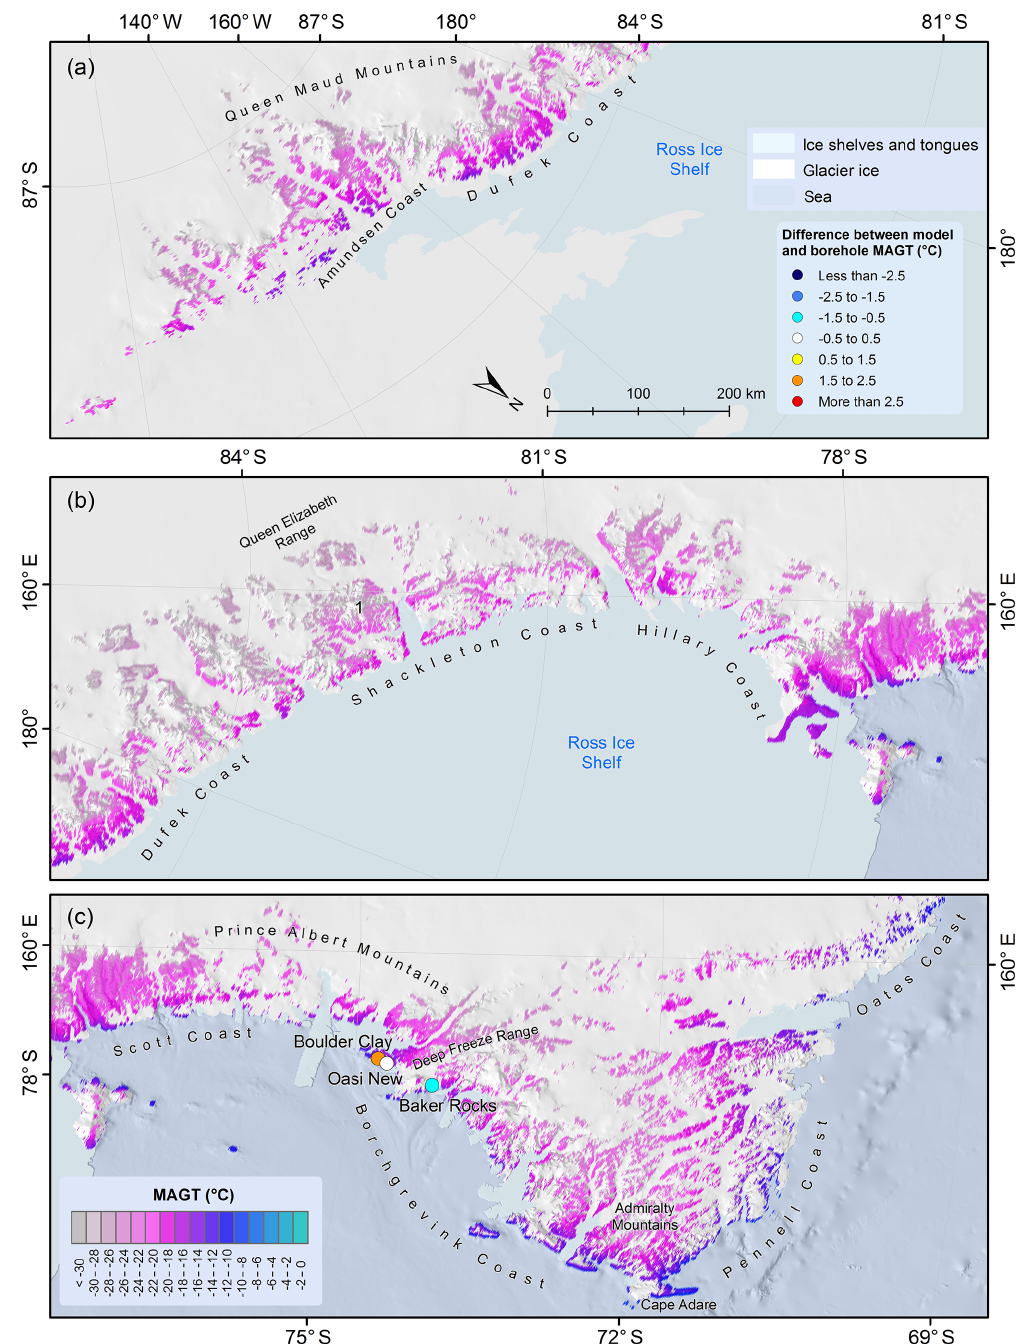
Figure 8. Permafrost temperature maps of the Transantarctic Mountains east of the 90 ◦ meridian and differences between borehole and modelled MAGT. Legends, scale and north arrow are valid for all panels. See Fig. 1 for location of panels (a) , (b) and (c)